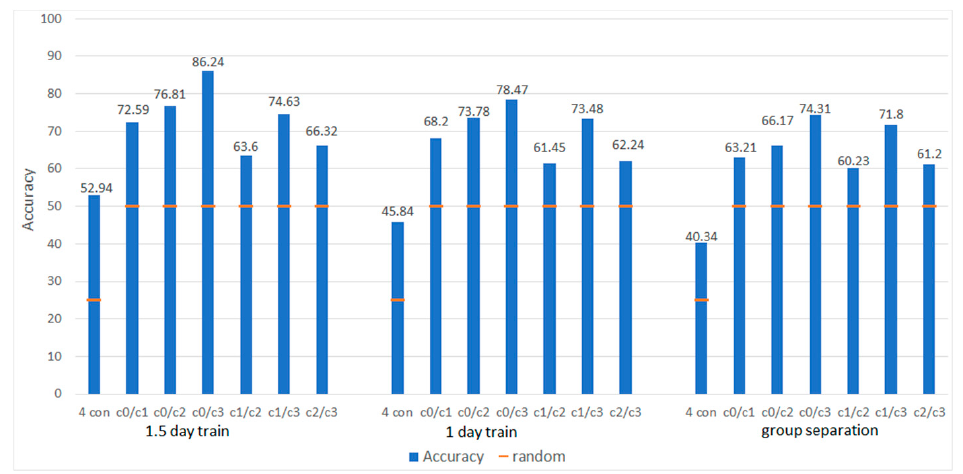
Figure 8. Accuracy of the ANN classifier for different train/test data divisions (training data from 1.5 day, training data from 1 day, training and validation data from separate subjects). The accuracy is shown for the separation of all four conditions (25% chance level, orange bar) and between each pair of conditions (50%). The classification accuracy profits from using data from the same day (1.5 day condition) and from the same subject (1 day condition) as well as from a stronger difference between the cognitive load conditions (e.g., L0–L3 versus L1–L2). This pattern suggests that inter- and intra-subject variance affect the performance but also that the network seem to rely on relevant cues since the separation is improving with the load difference.